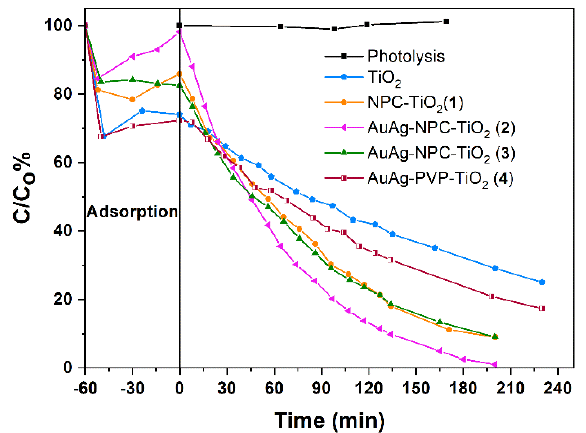
Figure 6. Evolution of ciprofloxacin concentration during its degradation with TiO 2 and nanohybrids 1–4 , under visible LED light.